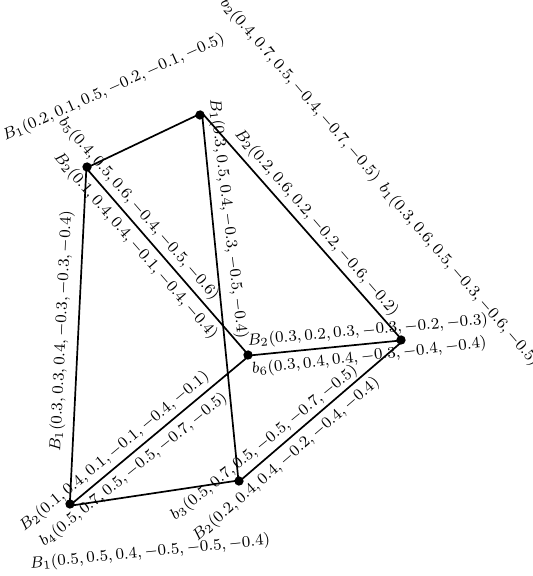
Figure 9. A BSVN fuzzy B 1 Figure 2.9: A BSVN fuzzy B 1 -tree